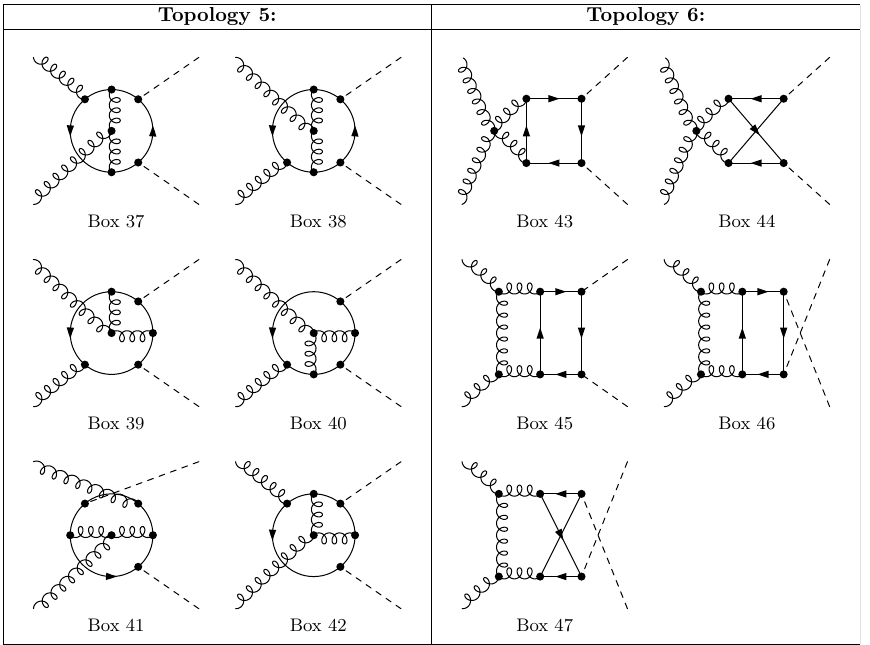
Figure 21 . Two-loop box diagrams: topologies 5 and